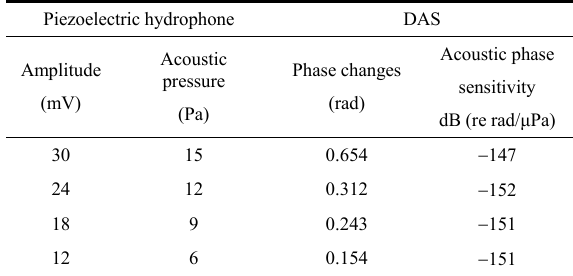
Table 1 Experimental data of